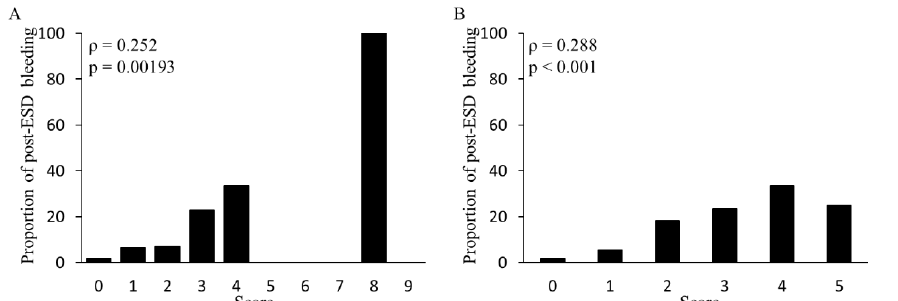
Figure 3. ( A ) BEST-J score points and percentage of post-ESD bleeding patients at each point in the